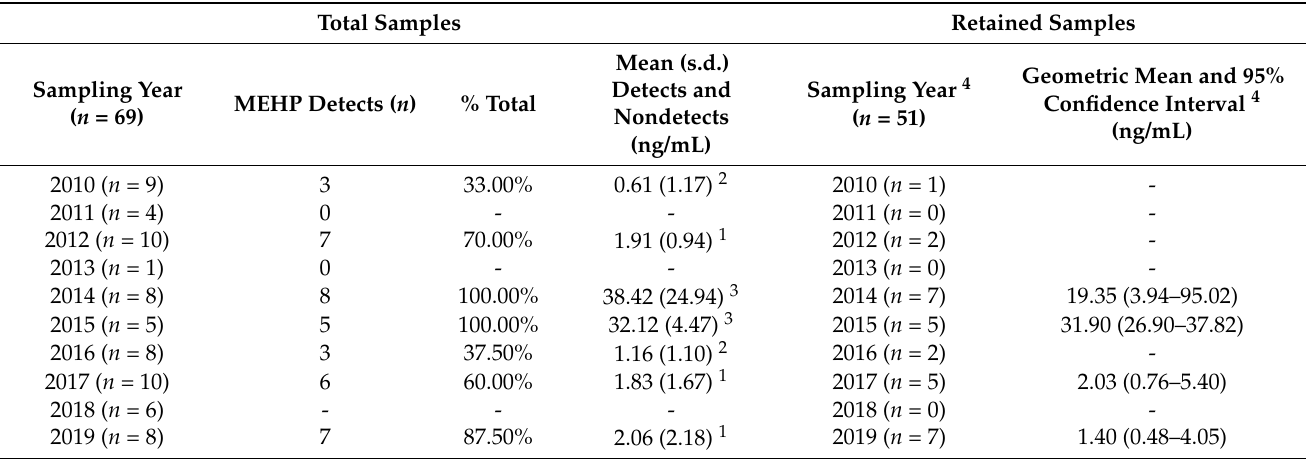
Table 1. Mono(2-ethylhexyl) phthalate (MEHP) screening results for Sarasota Bay bottlenose dolphin urine samples